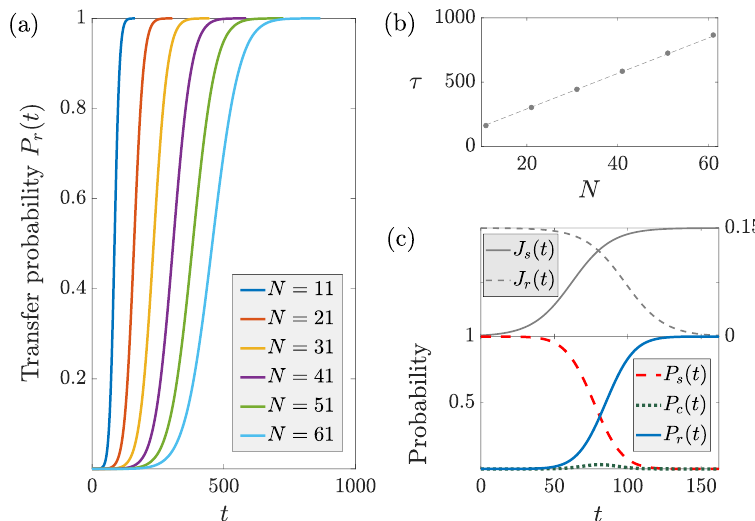
Figure 5: Stimulated adiabatic transfer of excitation between the sender and receiver spin using time-dependent couplings of Eq. (10), for chains with long-range exchange ( t ) vs time t (in units of interactions and no disorder. (a) Transfer probability P r 1 / J ) for chains of different length. (b) Transfer time τ (gray filled circles) as a function of N , and the linear fit τ J = 14.1 N + 6.9 (dashed line). (c) Top panel ( t ) of Eq. (10), and the bottom panel shows the time-dependent coupling rates J s , r ( t ) , receiver P ( t ) and shows the dynamics of excitation probabilities of the sender P s r ( t ) , for N = intermediate chain P c